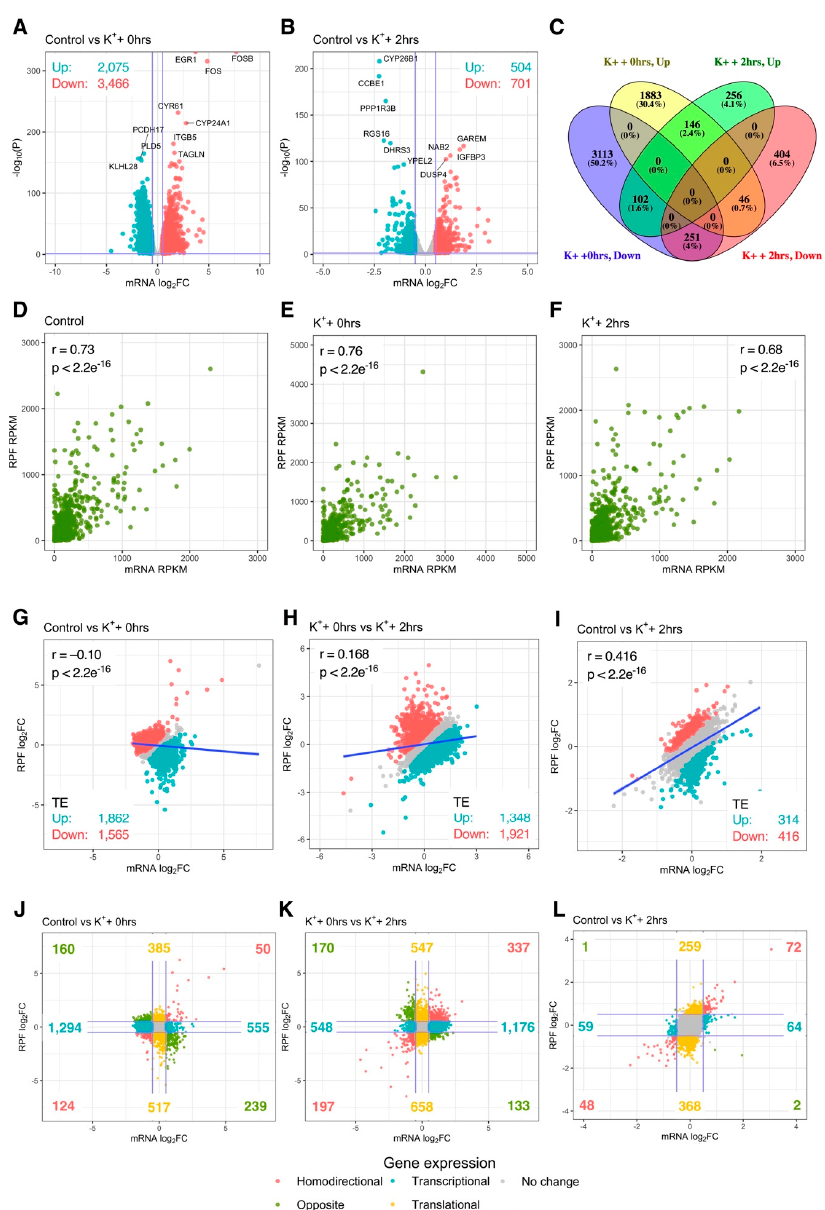
Figure 3. Interplay between mRNA abundance and translational activity. ( A , B ) Volcano plots comparing mRNA-Seq log 2 fold change (log 2 FC) and –log 10 p -values of genes immediately ( A ) or 2 h ( B ) after depolarization, relative to resting cells. Significantly upregulated and downregulated genes are marked in red and blue, respectively, with Benjamini–Hochberg FDR < 0.05 and log 2 FC > |± 0.5| considered significant. Horizontal line represents nominal p < 0.05. ( C ) Venn diagram depicting the overlap of significant genes between both time-points. ( D – F ) Gene-wise comparison of mRNA-Seq and Ribo-Seq RPKM in all experimental groups. Pearson’s correlation coefficient and associated p -values are reported (top left / right). ( G – I ) Gene-wise comparison of mRNA-Seq and Ribo-Seq log 2 FC. Pearson’s correlation coefficient and associated p -values are reported (top left). Genes with significantly increased or decreased translational efficiency (TE) are marked in red and blue, respectively. Dark blue line represents fitted linear model. ( J – L ) As in ( G – I ), except after categorizing genes based on expression at the mRNA and RPF levels. Blue lines represent log 2 FC = ± 0.5. “Homodirectional” refers to genes significantly altered at both the mRNA and RPF levels in the same direction; “Opposite” refers to genes significantly changed at both levels, but in opposite directions; “Transcriptional” refers to genes significantly altered at the mRNA level only; “Translational” refers to genes significantly changes at the RPF level